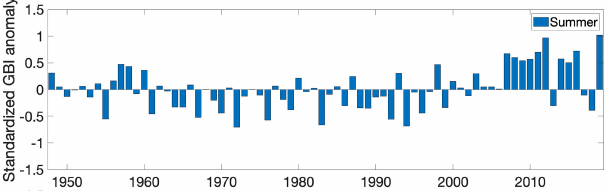
Figure 12. Standardized (1981–2010) (a) summer (JJA) averaged GBI values for the period